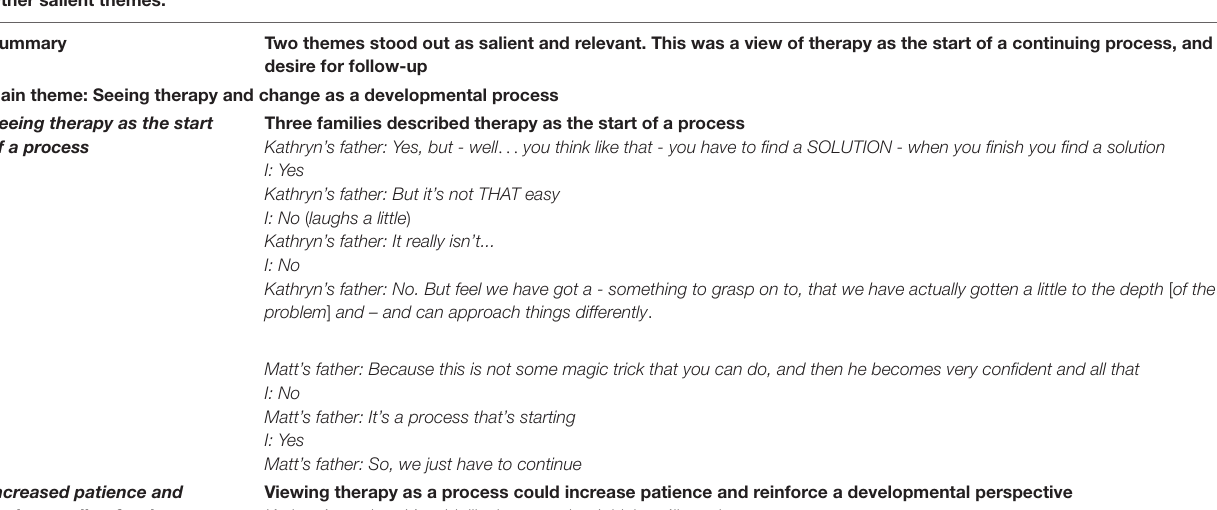
TABLE 7 | Other salient themes. Other salient themes: